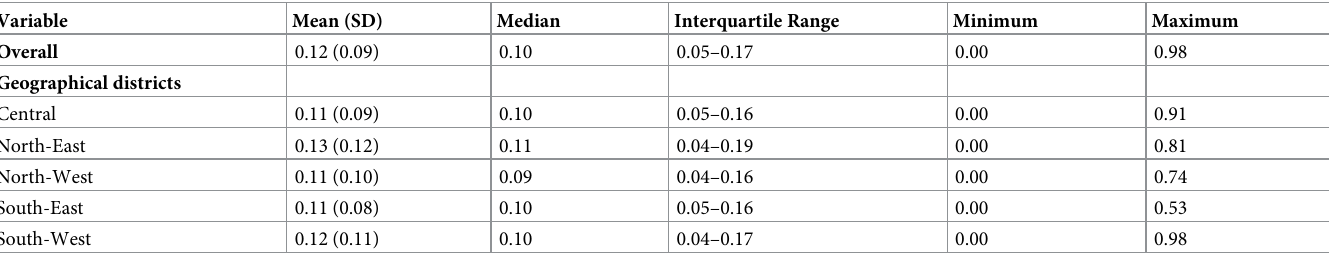
Table 1. Summary statistics of the mean Ae . aegypti trap rates, GI aeg . Interquartile range refers to the 1 st and 3 rd quartile.